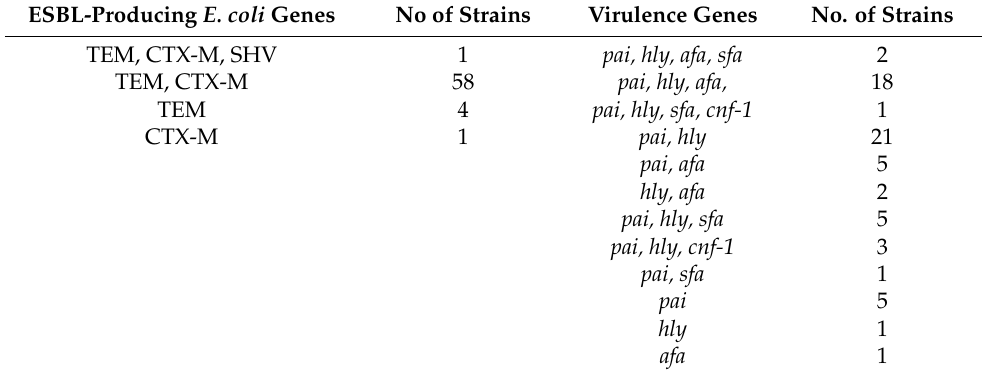
Table 1. Representation of the antibiotic resistance of ESBL-producing E. coli and the virulence gene distribution pattern among of isolates UPEC.